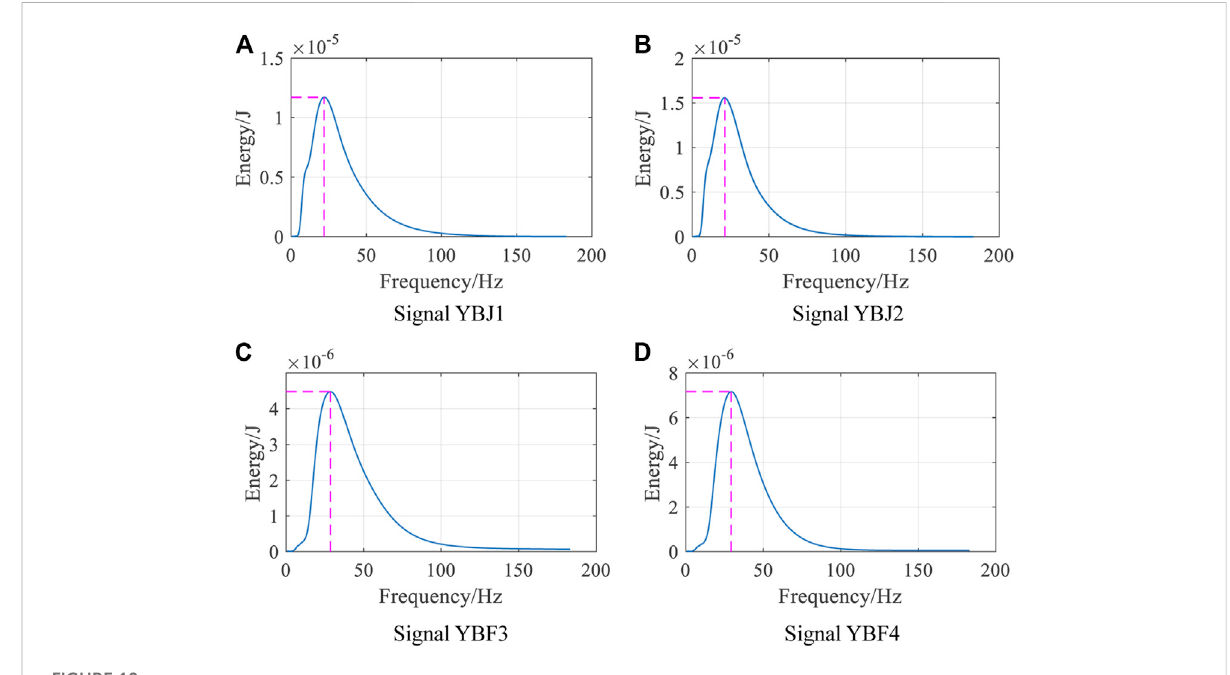
FIGURE 10 Scale energy spectrum of blasting vibration signals based on Db5 general wavelet.